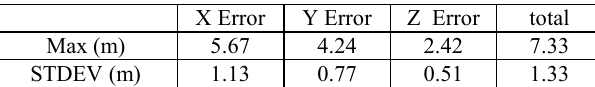
Table 4. The coordinate differences generated from forward intersections based on the RSM of original images and the RFM of SC